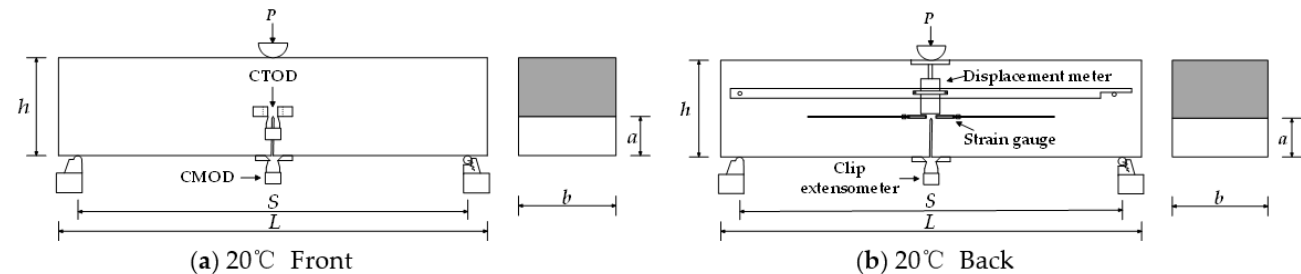
7 of 27 Figure 4. Changes in mass-loss rate and damage to appearances ( a ) and relative dynamic elastic